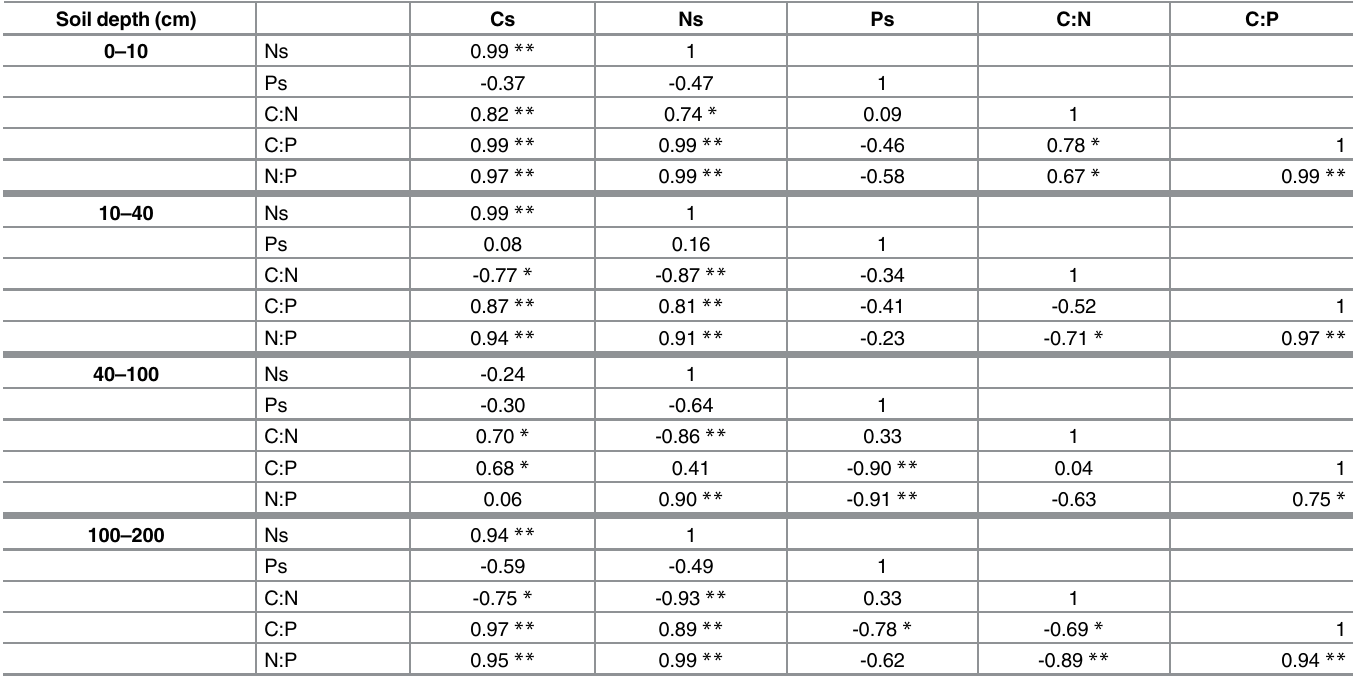
* Correlation signi fi cances were tested at P = 0.05 (P < 0.05) (1-tailed). ** Correlation signi fi cances were at P < 0.01